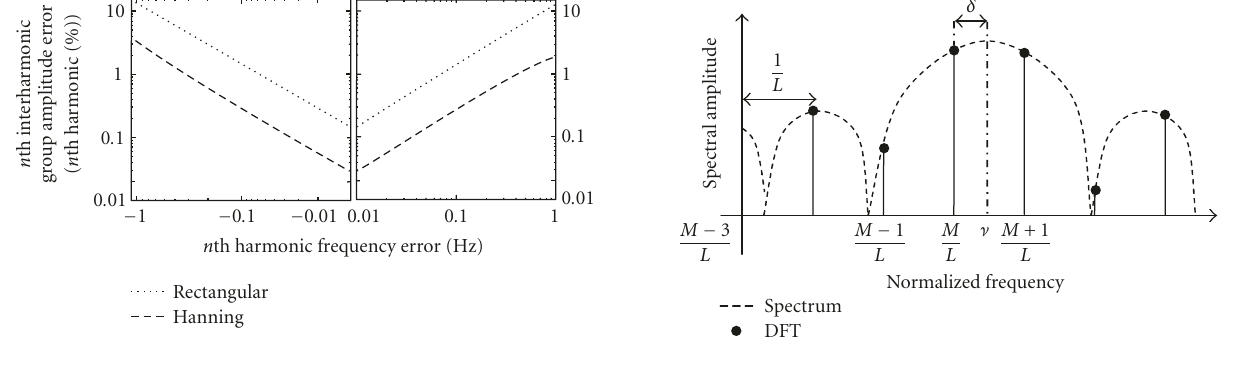
Figure 2: n th interharmonic group amplitude error versus n th har- monic frequency error: using RW (dotted line) and HW (dashed line).